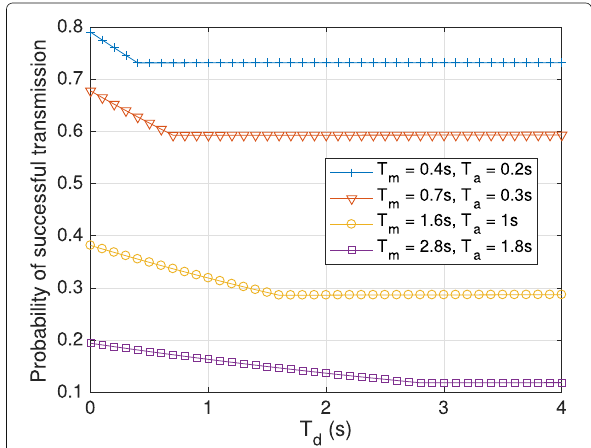
Fig. 11 Probability of successful transmission for λ T = 0.2 s − 1 and for different values of T m and T